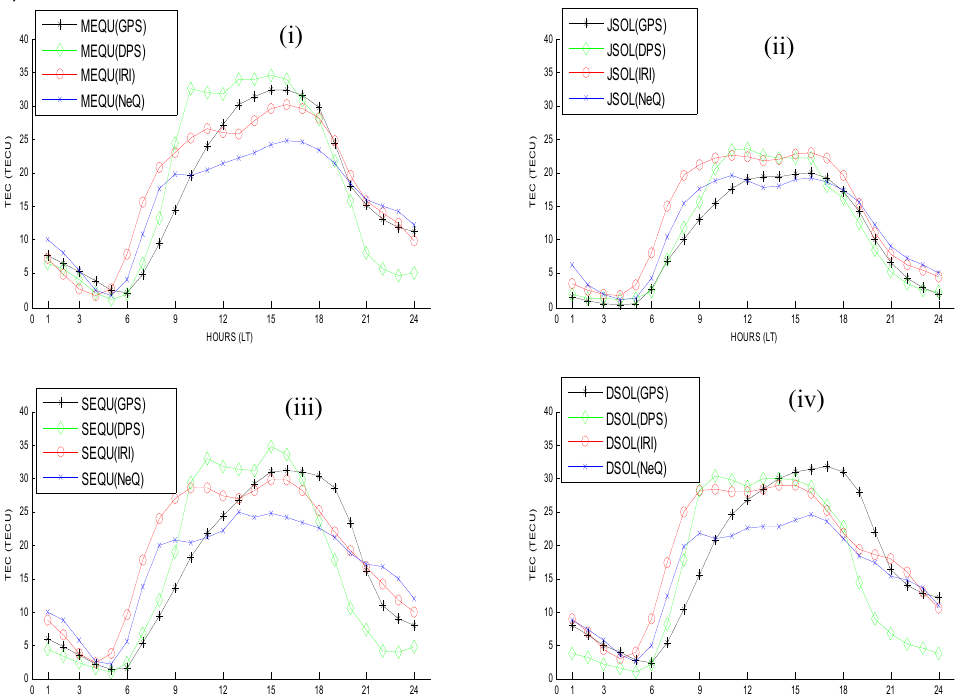
Figure 1. (a) Hourly variations in monthly median of five quiet days of GPS, DPS, IRI, and NeQ TEC in March–December during a quiet period. GPS TEC is denoted by the black line with the star symbol, DPS TEC is denoted by the green line with a diamond symbol, IRI TEC is denoted by the red line with the star symbol and NeQ TEC is denoted by the blue line with the star symbol. (b) Seasonal variations in GPS TEC, DPS TEC, IRI TEC, and NeQ TEC for the (i) March equinox, (ii) June solstice, (iii) September equinox, and (iv) December solstice over Ilorin during quiet periods in 2010. The line colors and symbols are the same as for diurnal variation in Fig. 1a for all seasons.